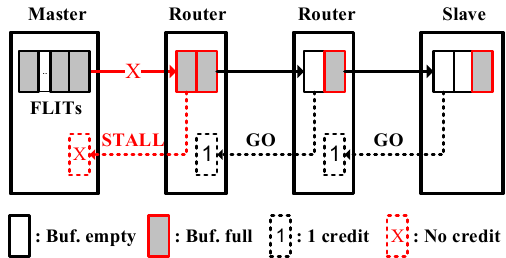
Figure 9. STALL/GO protocol implementation. Figure 9. STALL / GO protocol implementation.